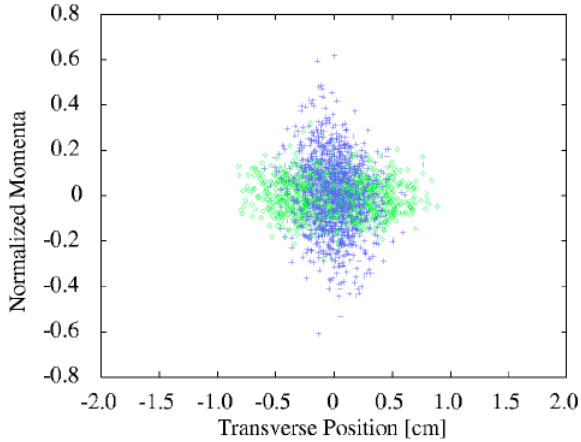
FIG. 17. (Color) Transverse phase-space distributions (horizon- tal: green diamonds; vertical: blue crosses) after 40 rf cavities in afterburner